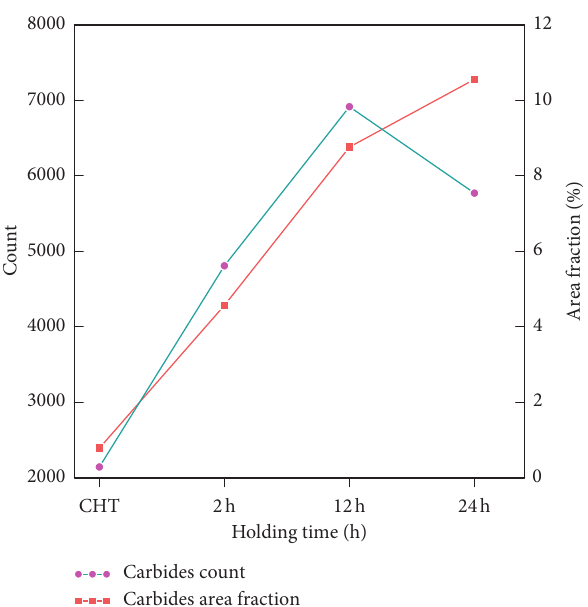
13: The number of precipitated carbides of CHT and CTs with different holding